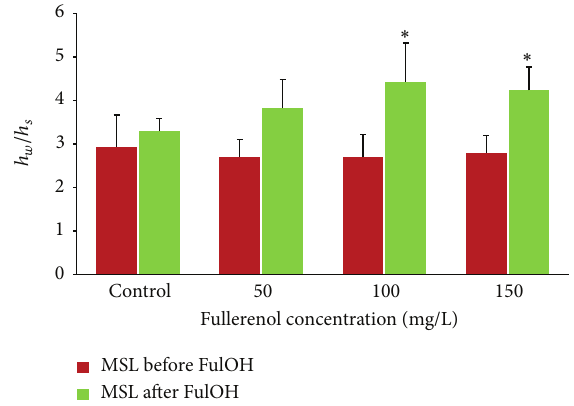
Figure 6: The influence of fullerenol on the membrane protein conformation ( ℎ 𝑤 / ℎ 𝑠 parameter) of MSL-labeled membranes. (1) Erythrocyte membranes were incubated with MSL for 1h at 4 ∘ C, and then spin-labeled membranes were incubated with fullerenol at 50, 100, and 150mg/L for 1 h at 37 ∘ C (“MSL before FulOH”). Bars are mean ± SD for three independent samples. (2) Erythrocyte membranes were incubated with fullerenol at 50, 100, and 150 mg/L for 1h at 37 ∘ C, and then membranes were incubated with MSL for 1h at 4 ∘ C (“MSL after FulOH”). Bars are mean ± SD for four independent samples. Controls are membranes incubated only with MSL according to the scheme detailed above. ∗ values statistically different in comparison with control values, 𝑃 < 0.05